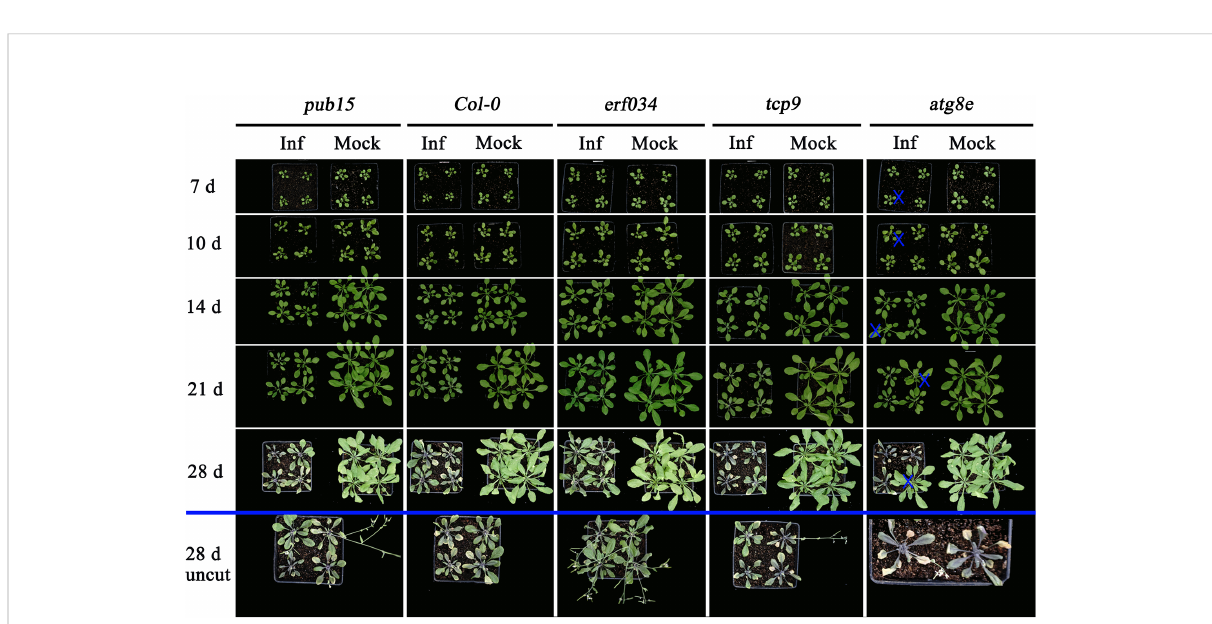
FIGURE 7 Clubroot disease development in A. thaliana for retesting. The plants below the blue line indicates the uncut above-ground portion, “ × ” indicates the single plants inoculated with sterile water in the atg8e treatment group.